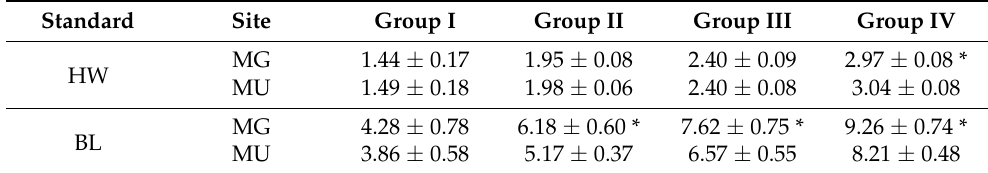
Figure 6. The relationship between head width and body length of Nannophya koreana larvae at the two study sites. The larvae were divided into four groups according to their size. Table 2. Comparison of head width (HW) and body length (BL) of Nannophya koreana larvae at the two study sites (mean ± SE).